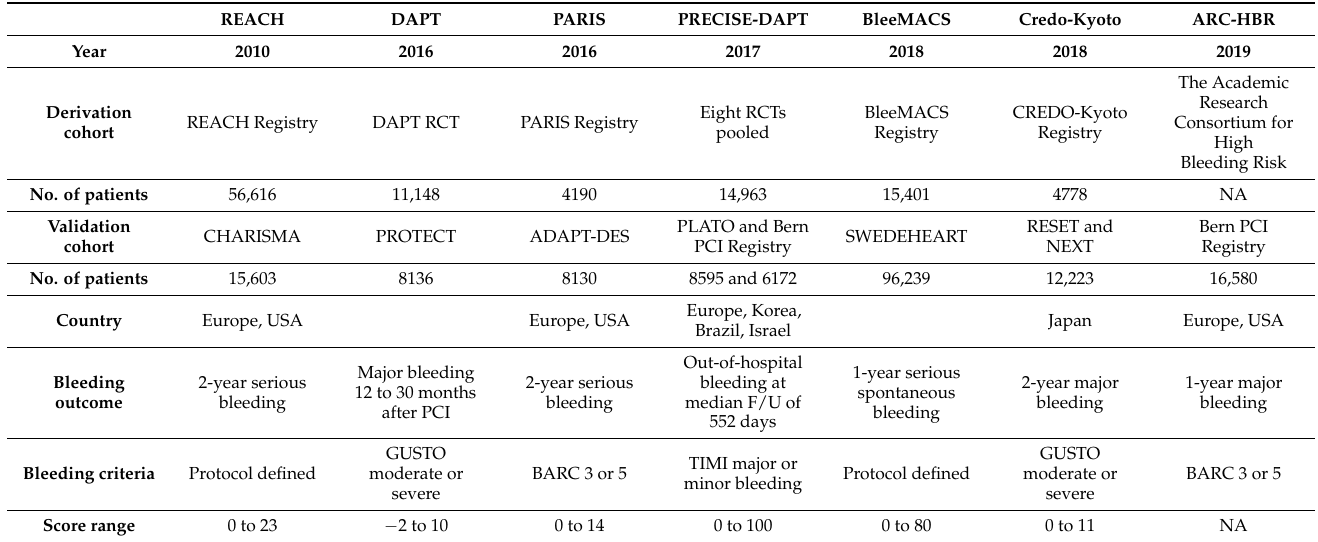
Table 1. Scores specifically derived for assessing long-term bleeding risk in patients taking dual antiplatelet therapy after percutaneous coronary